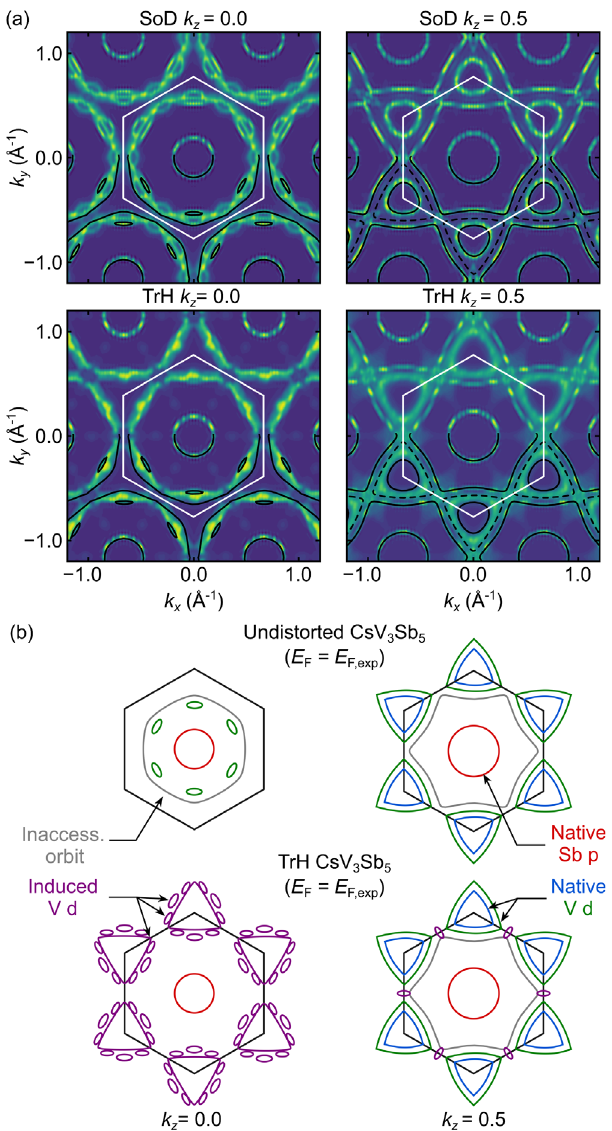
FIG. 8. (a) Fermi surfaces for the SoD and TrH distortions in CsV 3 Sb 5 generated from the unfolded supercell band structures. Undistorted Fermi surface (black lines) contours are shown for comparison. A significant reconstruction of the V d states occurs. Most high-frequency modes are preserved, though the C-II orbit (dashed line) is gapped in the SoD structure. (b) Schematic description of Fermi surface reconstruction. Gray orbits are well above measurable frequencies. Band reconstruction in the TrH supercell introduces one additional triangular orbit around the M point while preserving higher-frequency native V d and Sb p orbits. Notably, the distortion also introduces three, smaller, Dirac-like orbits (purple) shown in Fig. 4, consistent with our measurements.